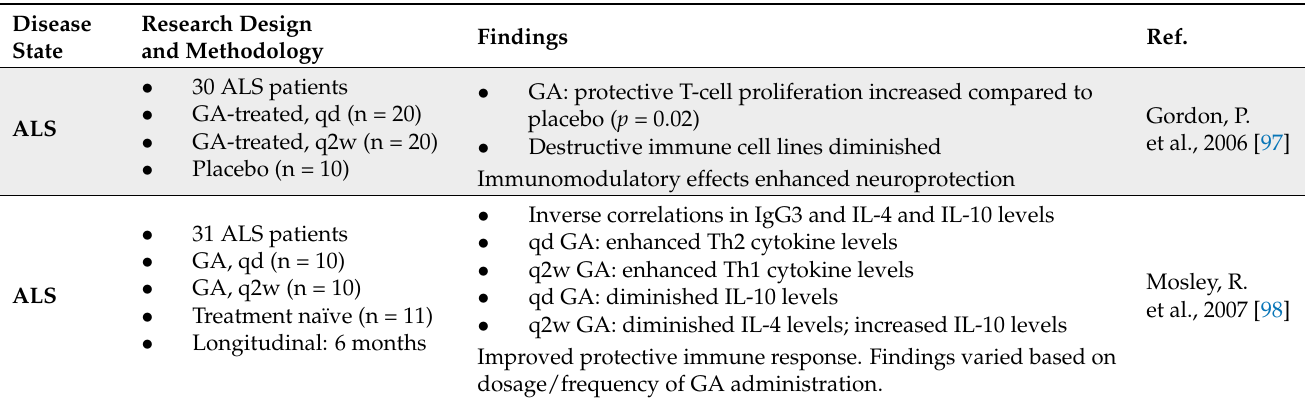
Table 3. Clinical Trials Examining Alternative Glatiramer Acetate Uses in Amyotrophic Lateral Sclerosis